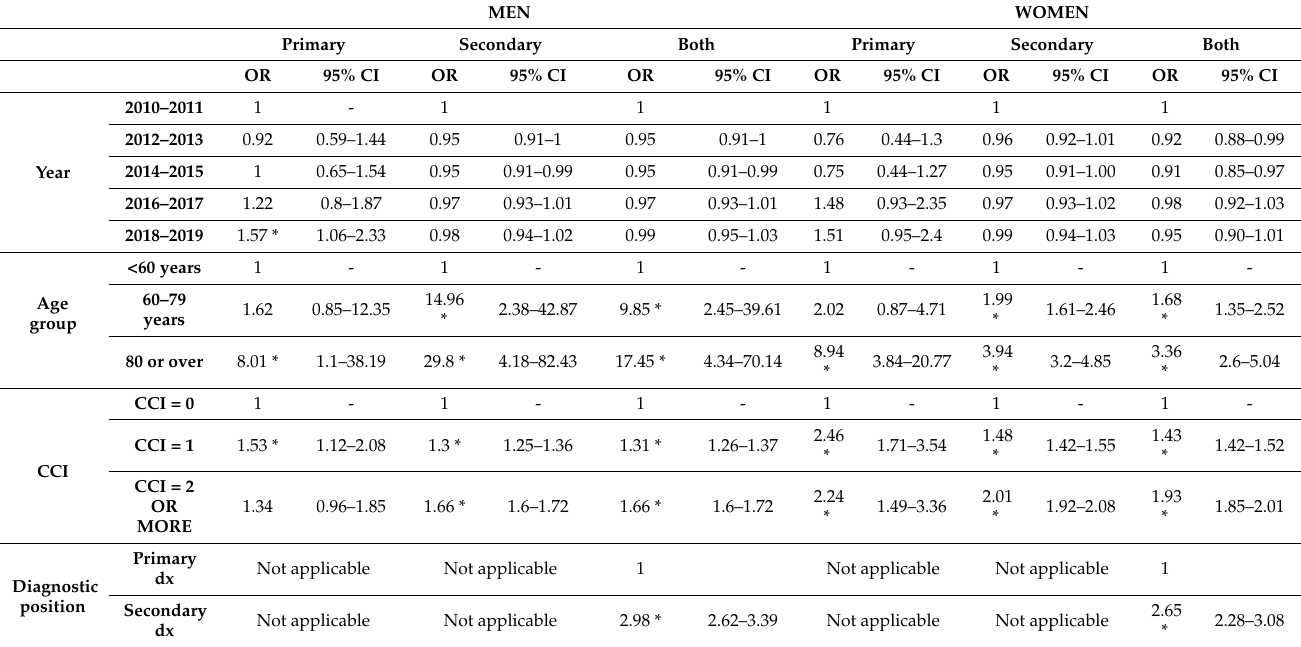
Table 7. Multivariate analysis of in-hospital mortality among patients with Parkinson’s disease codified as a primary or secondary diagnostic position and stratified by sex. Spain,